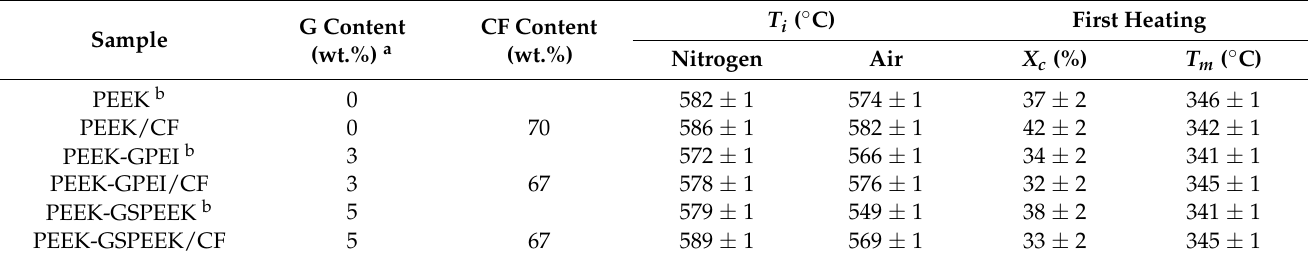
Table 1. Thermal parameters obtained from TGA and